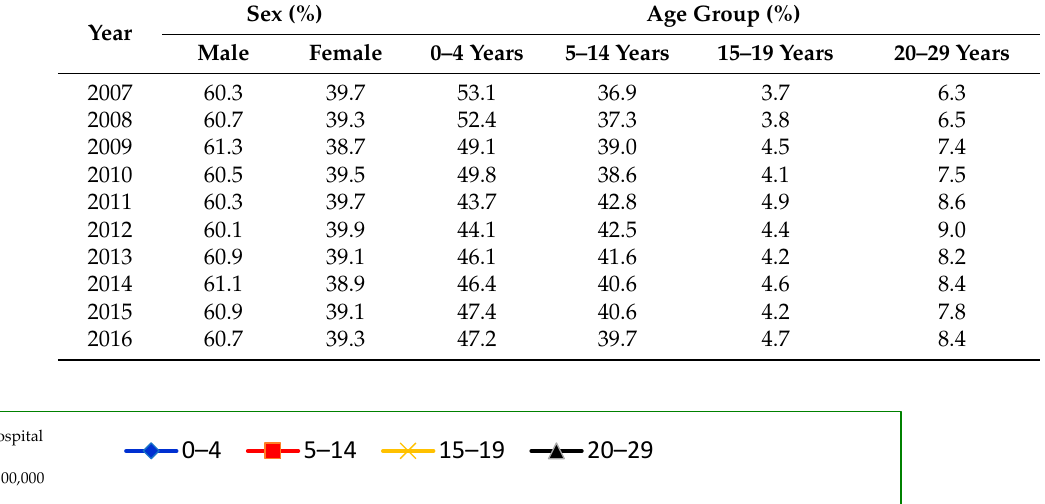
Table 1. Number and percentage of asthma admissions by age and sex distributions during the study periods of 2007–2016.